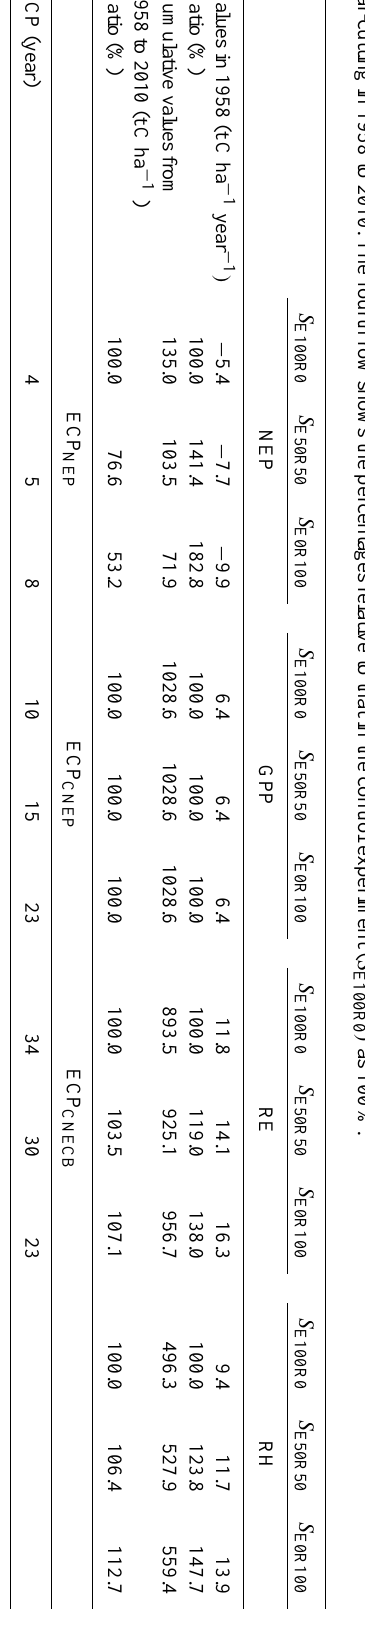
(a) Clear (cid:239) cutting